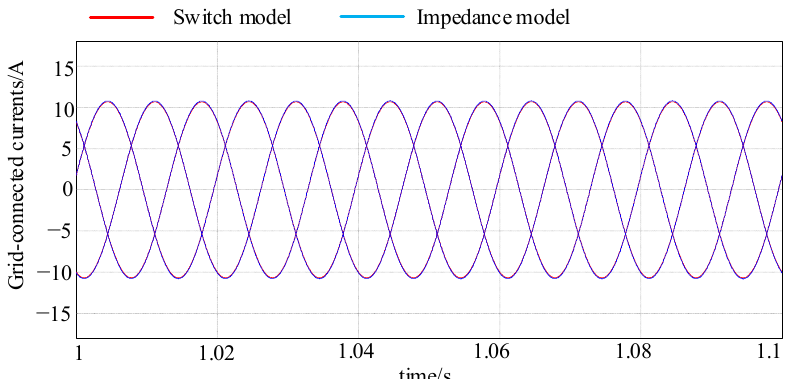
Figure 13. Simulation results of the current in the switch model and impedance model in an ideal grid.